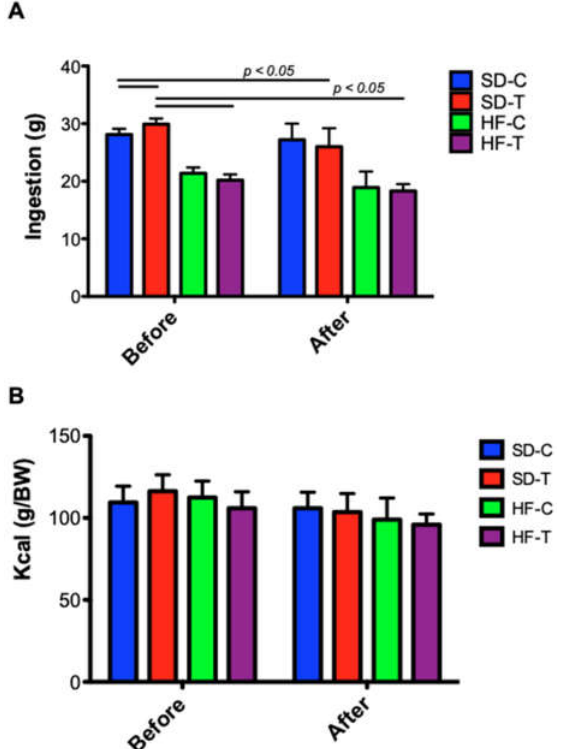
Figure 3. Food intake and kilocalories ingested by all animal groups. ( A ) Significant differences of food intake between the control groups when compared to respectively exercised groups (diet vs. training, p > 0.05, diet, p < 0.05, and training, p < 0.05). ( B ) There is no difference in caloric intake between groups.